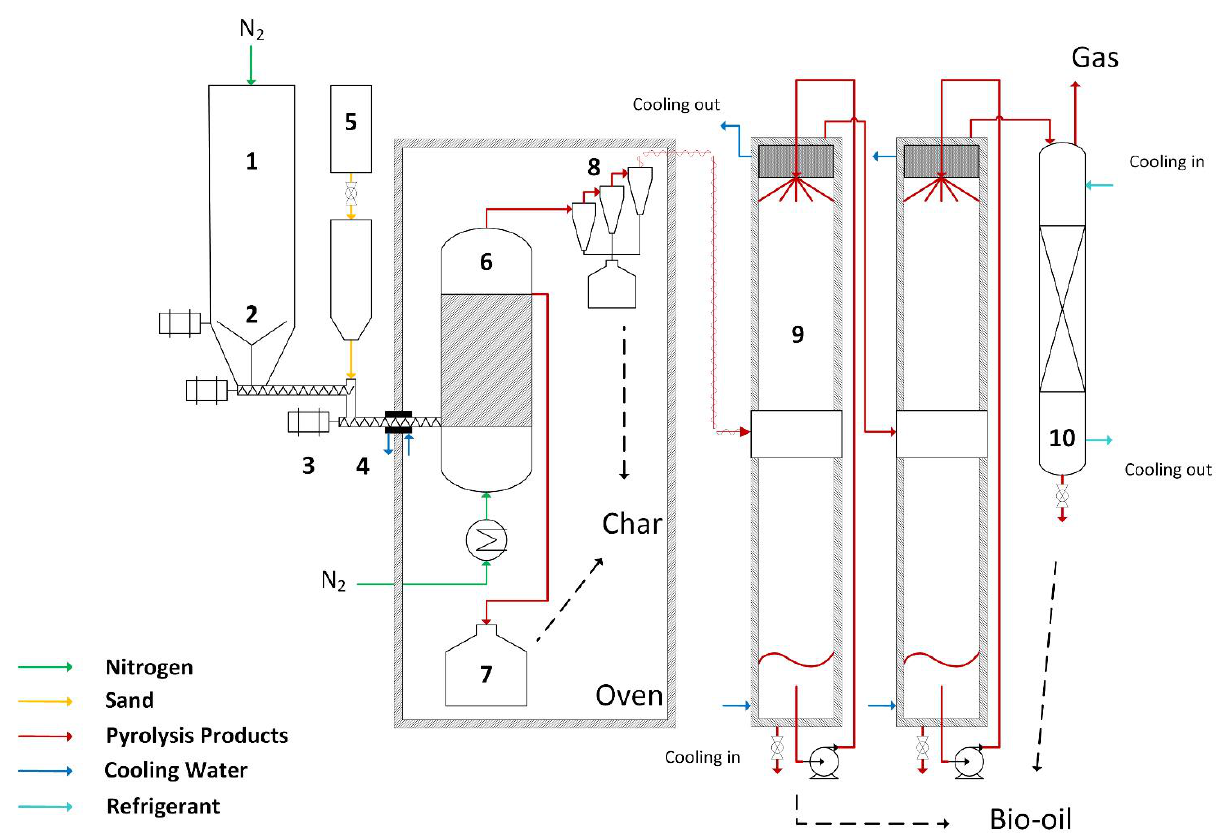
Figure 1. Layout of the pyrolysis unit connected to the fractional condensation train: (1) biomass storage hopper; (2) mechanical stirrer; (3) feeding stirrer; (4) cooling jacket; (5) sand storage hopper; (6) fluidized bed reactor; (7) overflow vessel; (8) cyclones; (9) spray condensers; (10) intensive cooler. Adapted from [29].